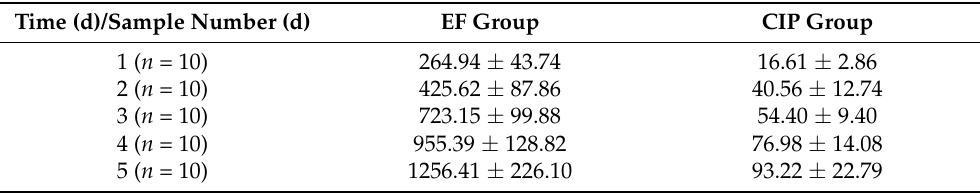
Table 7. Residual concentrations of EF after EF soluble powder combined with TIM soluble powder in eggs (mean ± SD, n = 10) ( µ g/kg).